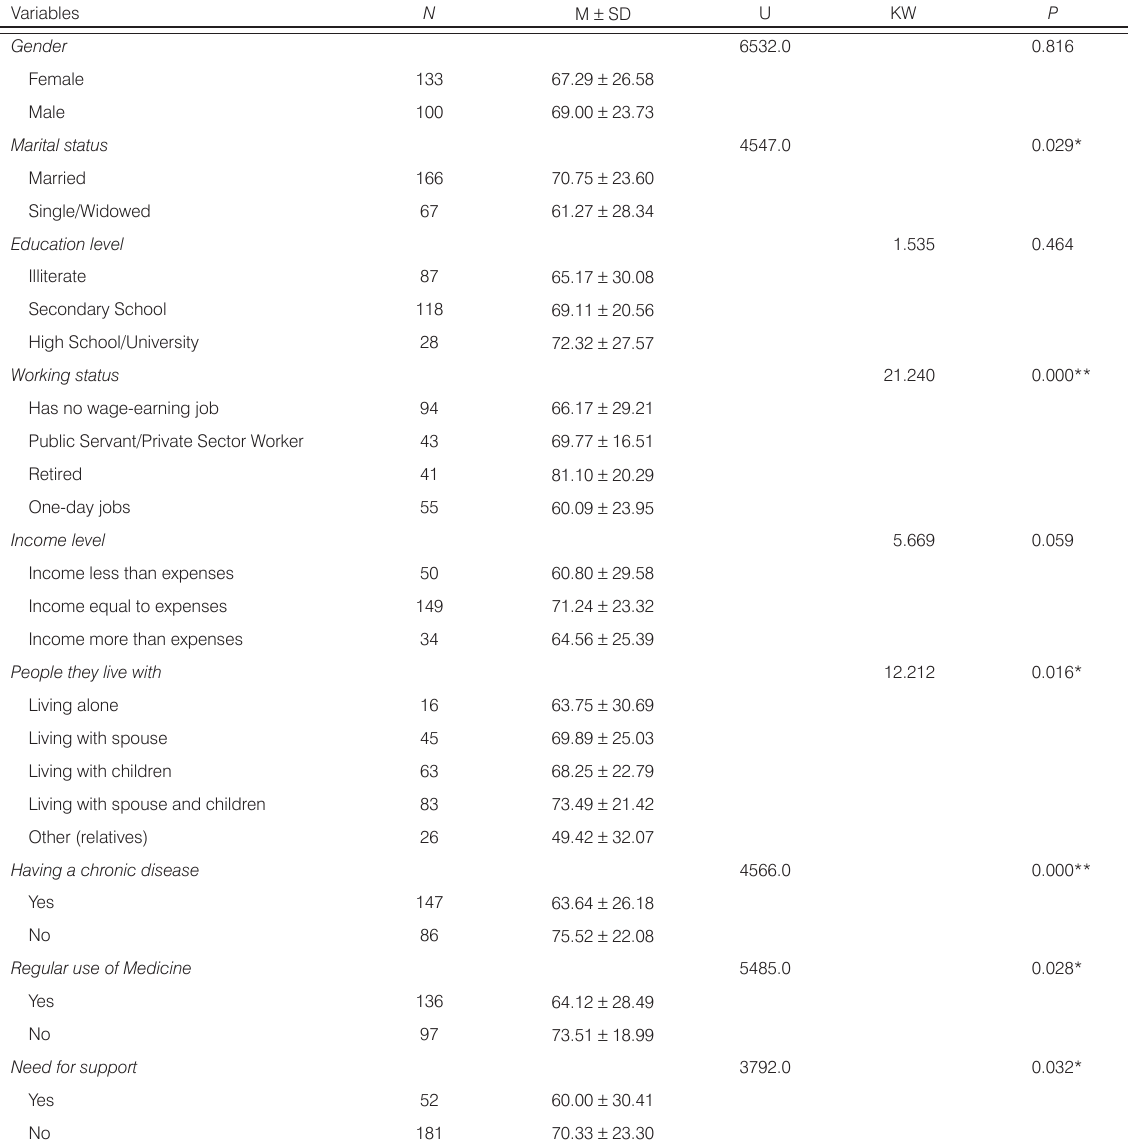
Table 4. The Participants’ Barthel Index of activities of daily living scores distribution according to socio-demographic features ( n =